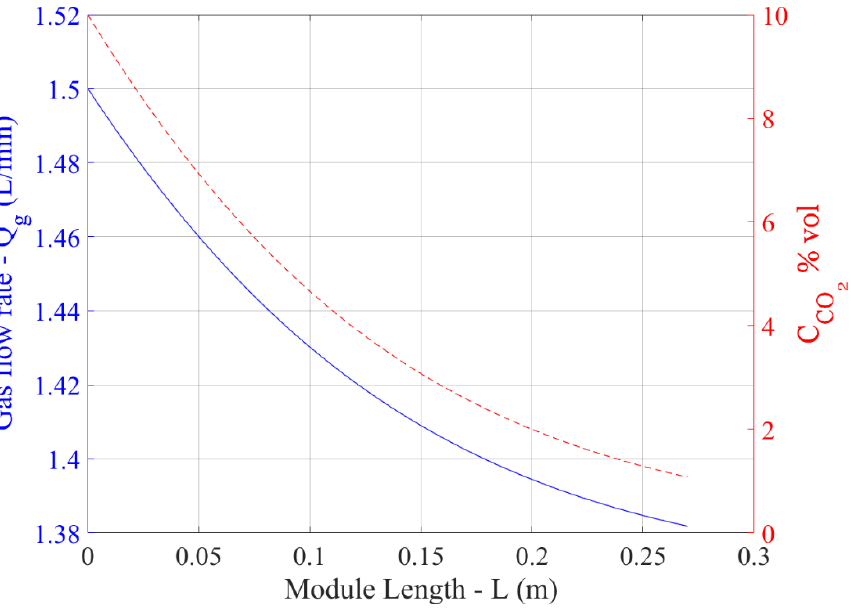
Figure 7. Gas flow rate and CO 2 gas concentration profiles over the module length, Q L